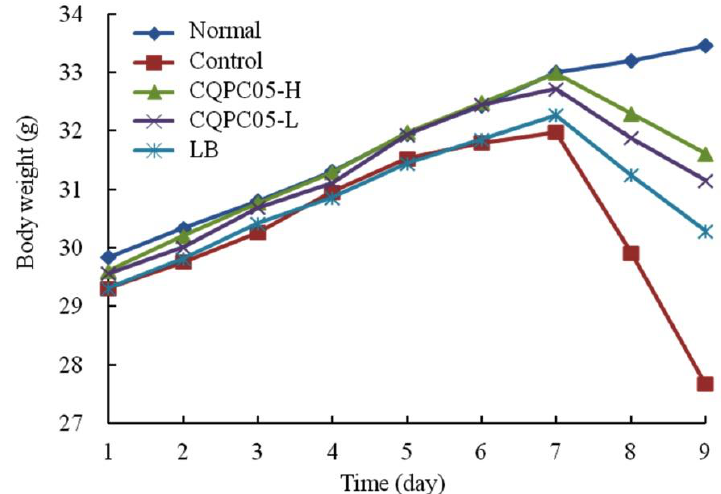
Figure 2. Weight changes of mice in each experimental group (average value of 10 mice in each group). LB: Lactobacillus delbrueckii subsp. bulgaricus (1.0 × 10 9 colony-forming unit (CFU)/kg body weight (bw)); CQPC05-L: Lactobacillus plantarum CQPC05 low dose (1.0 × 10 8 CFU/kg bw); CQPC05-H: Lactobacillus plantarum CQPC05 high dose (1.0 × 10 9 CFU/kg bw).